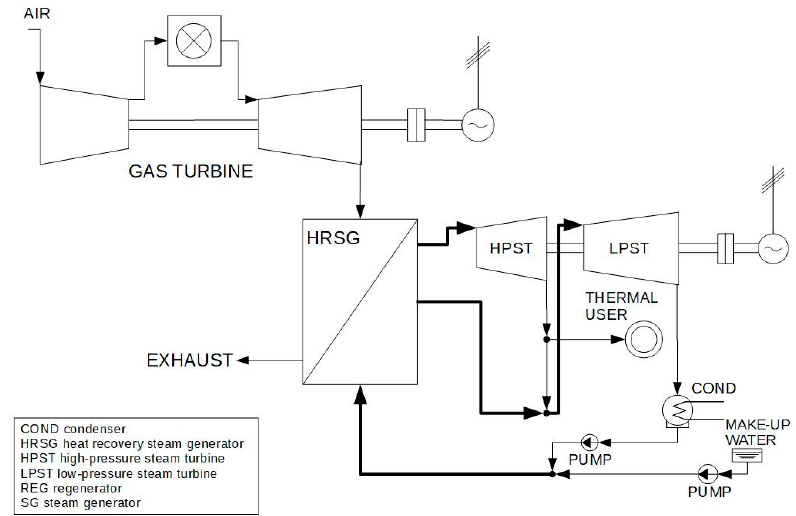
Figure 7. Scheme of the combined cycle cogeneration unit taken into consideration.